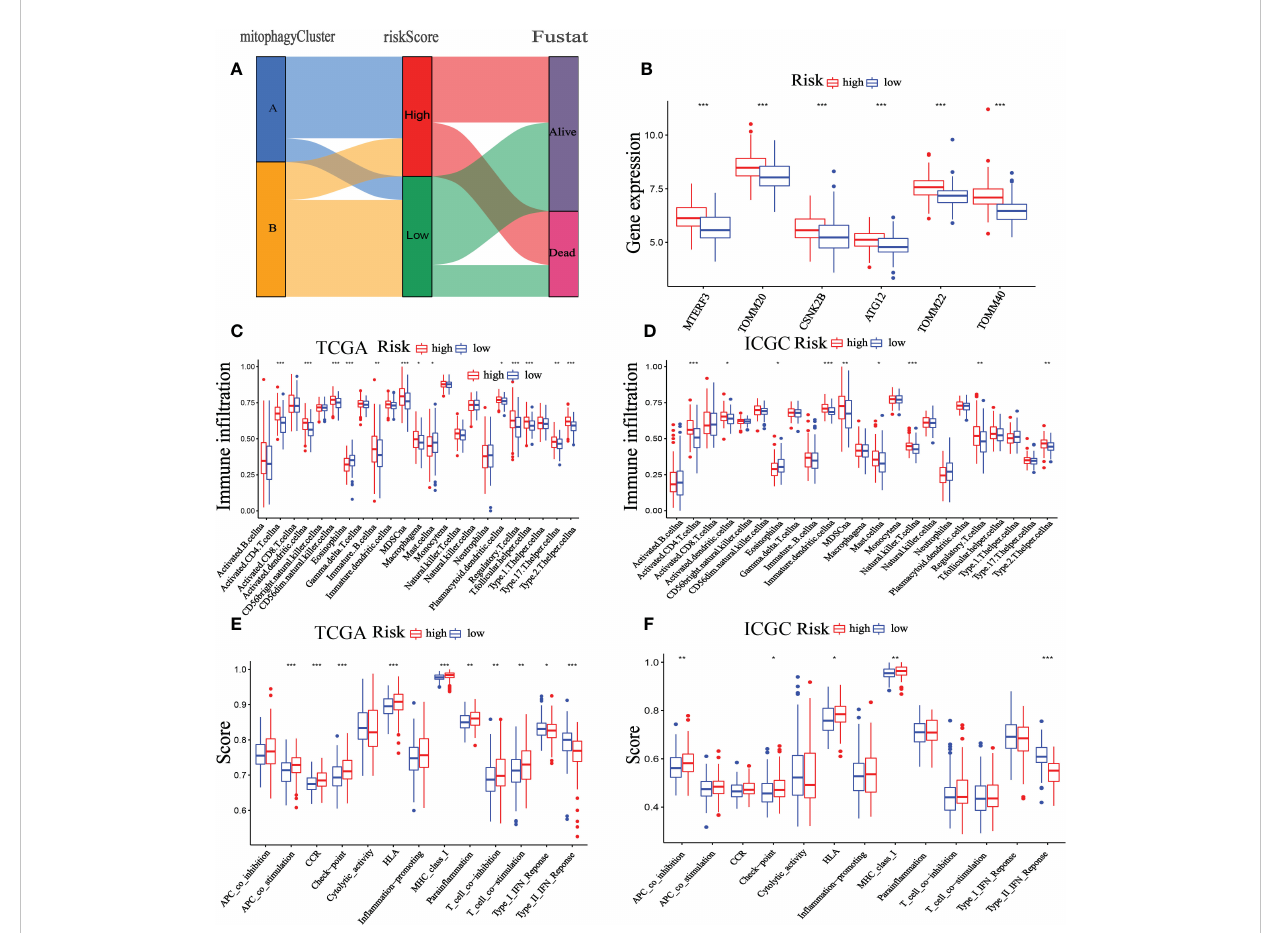
FIGURE 10 Correlation between the TIME and mitophagy signature. (A) The Sankey diagram shows the distribution of high-risk groups and low-risk groups in cluster A and cluster B patterns. (B) Expression of the mitophagy-related gene in the low-risk group and high-risk group. The ssGSEA results of different risk groups in the TCGA cohort (C, E) and ICGC cohort (D, F) . The 23 immune cell scores (C, D) and 13 immune-related functions (E, F) were shown in boxplots. *p < 0.05; **p < 0.01; ***p <